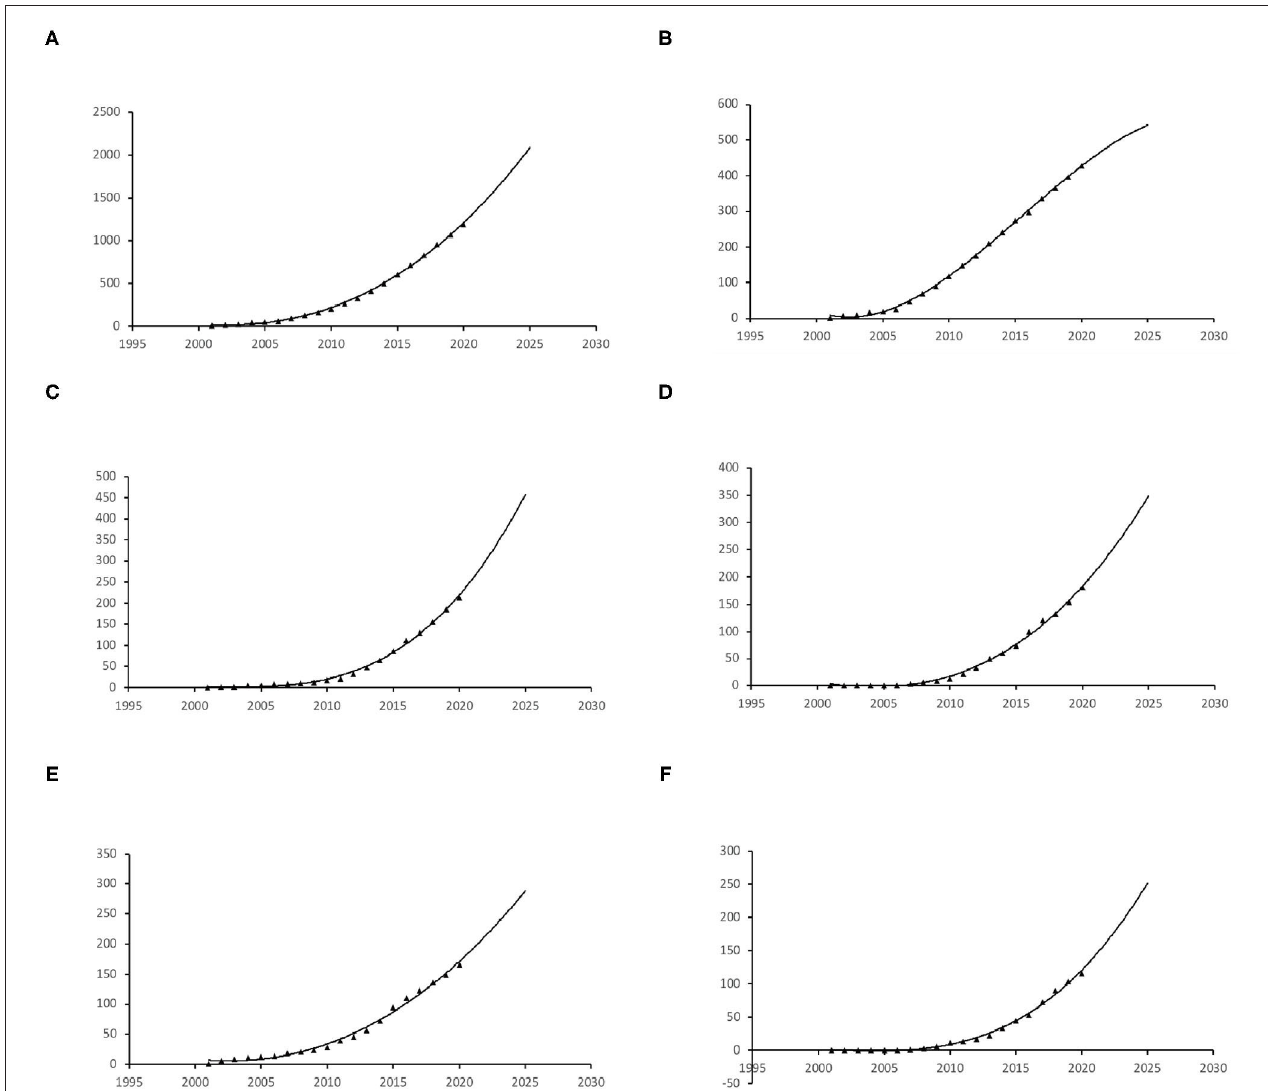
FIGURE 2 | The publication growth trends of in the past 20 years and prediction curve. (A) Global, (B) Japan, (C) China, (D) South Korea, (E) USA, (F)